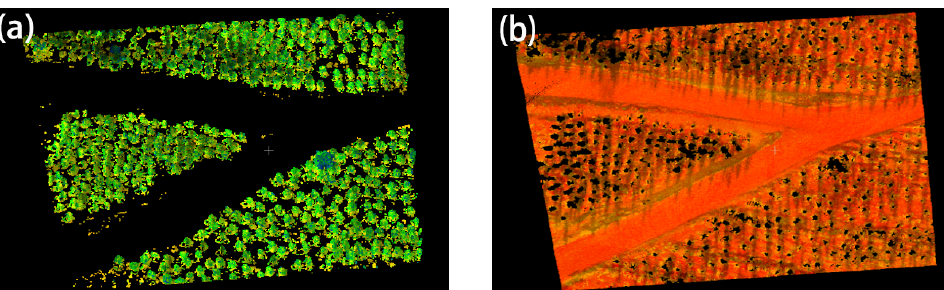
Figure 19. The point clouds of the Figure 17 is segmented according to the intensity: ( a ) is the non-ground points; ( b ) is the ground points.